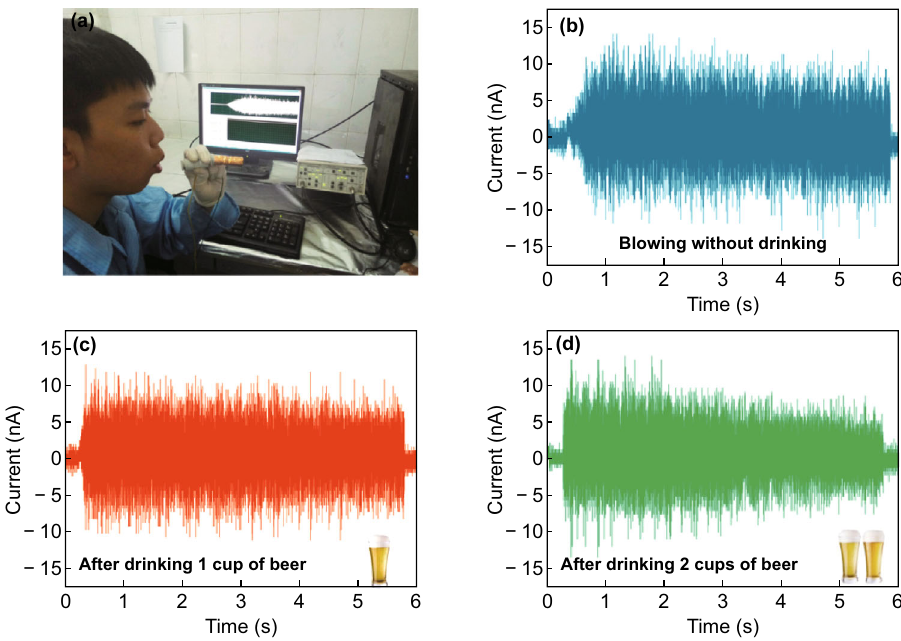
Fig. 9 Demonstration of self-powered PANI/PVDF breath analyzer. a Photograph of the measurement platform. b – d The output current of the device in response to blowing by an adult. b Without drinking, c after drinking one cup of beer, and d after drinking two cups of